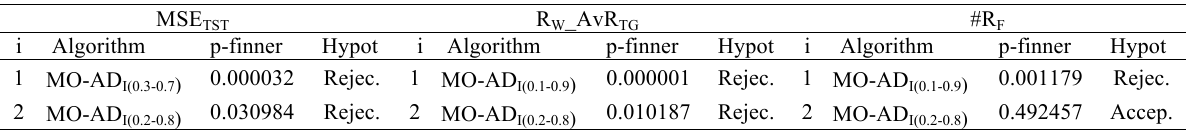
Table A.8 Finner Table with α = 0.05 for the methods on MSE TST , R W _AvR TG and #R F measures on MAX ACC point using